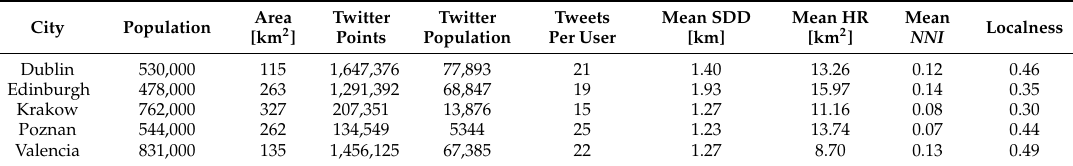
Table 1. Cities and spatial characteristics of Twitter population. Based on D1 dataset—see